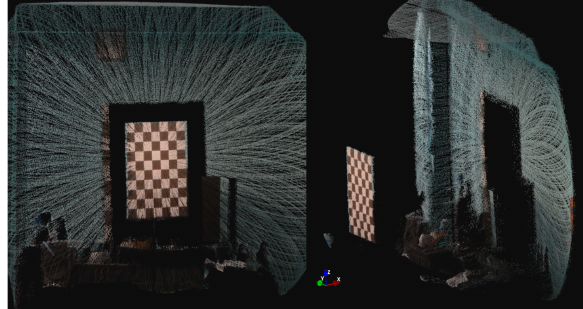
Figure 11. Perspective view of test scan point cloud